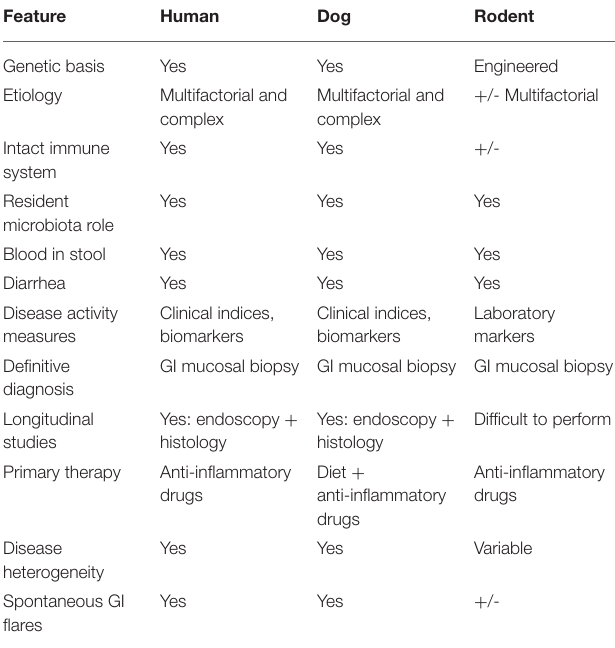
TABLE 3 | Comparative features of IBD in different animal models.